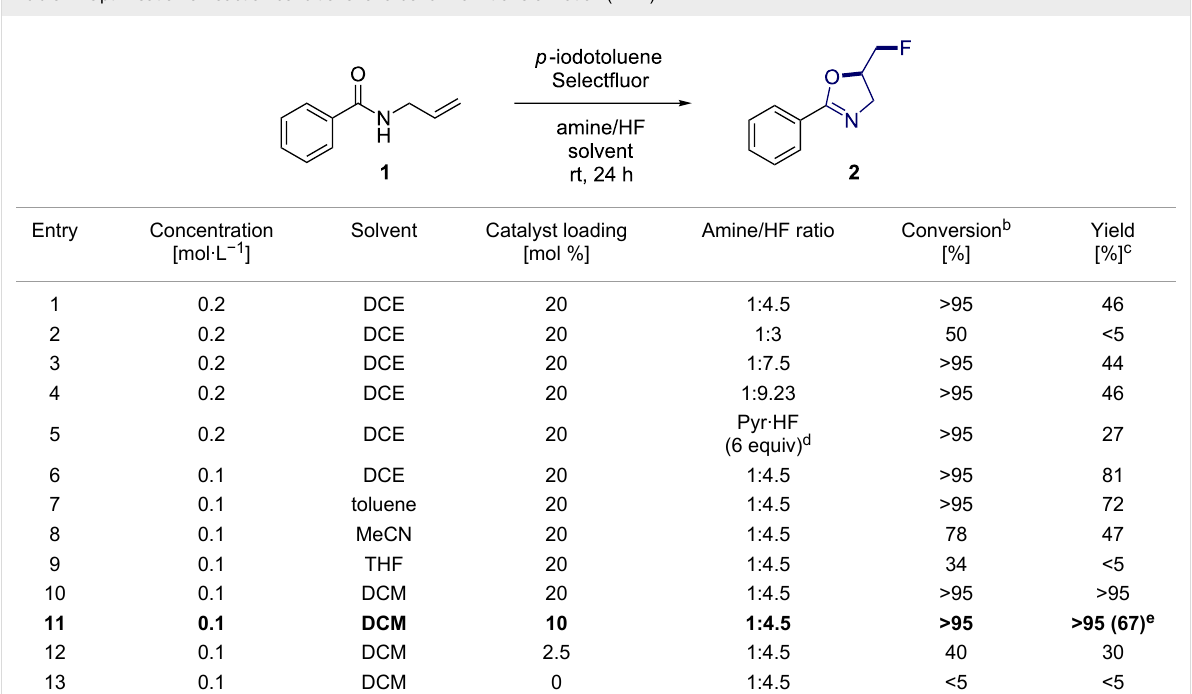
Table 1: Optimisation of reaction conditions for a benchmark transformation ( 1 → 2 ).